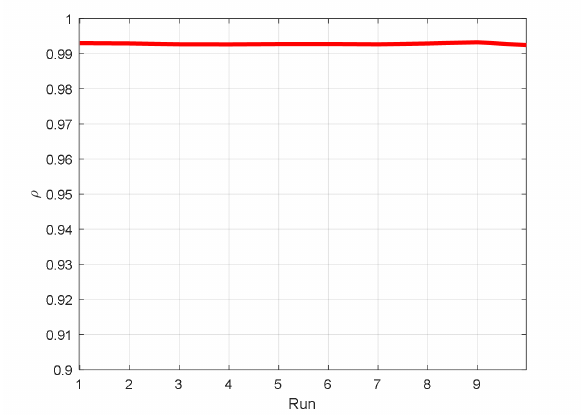
Figure 8. ρ versus number of